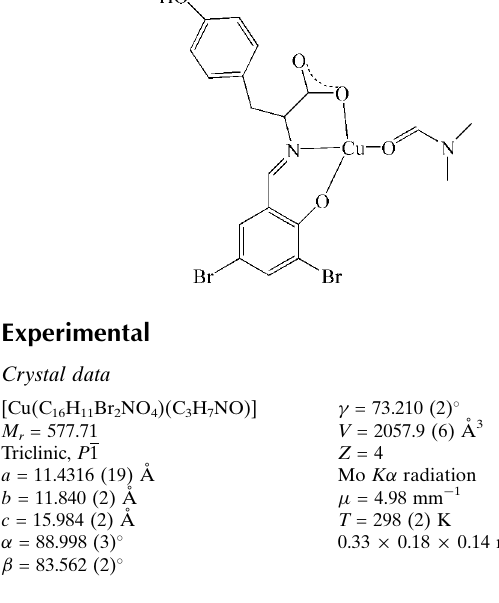
Absorption correction: multi-scan ( SADABS ; Sheldrick,1996)